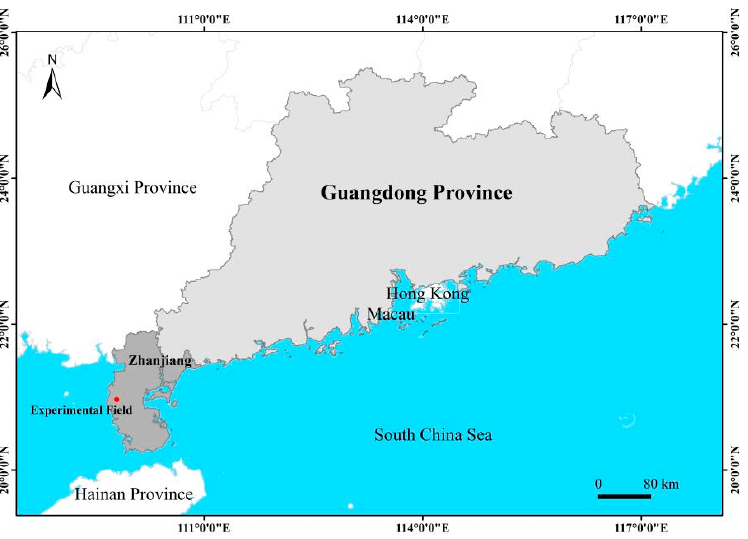
Figure 1. Location of the experimental field in Zhanjiang City, Guangdong Province, China.